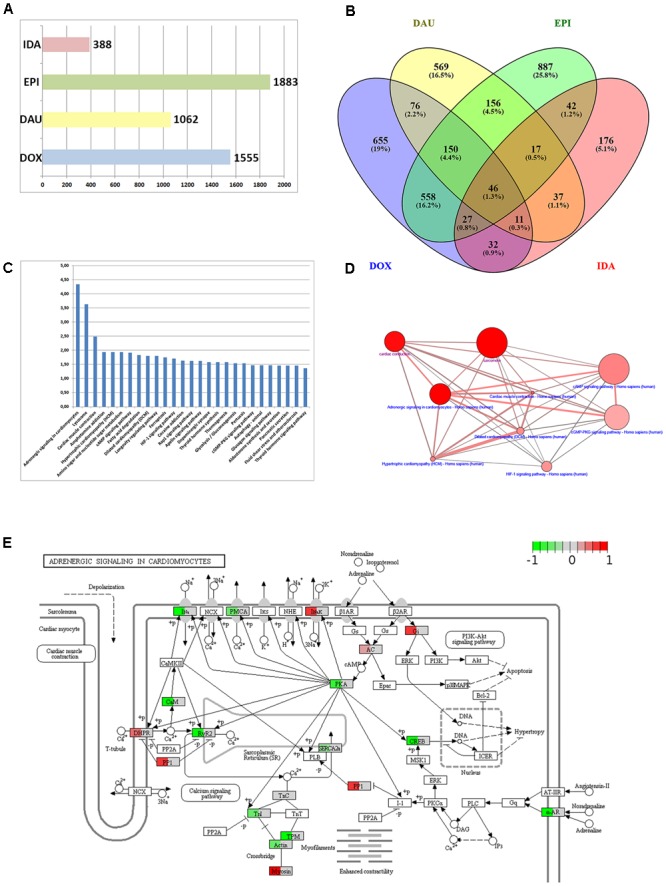
Anthracycline over-representation analysis. (A) Summary of the number of DEGs from the different experimental conditions: DOX (3 mg/kg at 1, 3, and 5 days), DAU (3.25 and 2 mg/kg at 1, 3, and 5 days), EPI (2.7 mg/kg at 1, 3, and 5 days), and IDA (0.625 mg/kg at 1, 3, and 5 days). (B) VENN diagram of DEGs with respect to the four compound treatments. (C) 27 KEGG pathways that were found significantly over-represented with respect to the 1555 DEGs after DOX treatment using the Fisher test statistic with the ConsensusPathDB. Y-axis = –log10(P-value). (D) Interdependency of significant pathways from (C) (blue label) and GO categories (magenta label) computed with ConsensusPathDB. Size of balls indicates pathway size, shade of balls indicate overlap with DEG list. (E) “Adrenergic signaling in cardiomyocytes” pathway found significantly over-represented (P = 3.49E-07) and expression data of 32 DEGs overlaid with the pathway. Mapping of gene expression fold-changes to pathway has been done with Pathview (Luo et al., 2017).